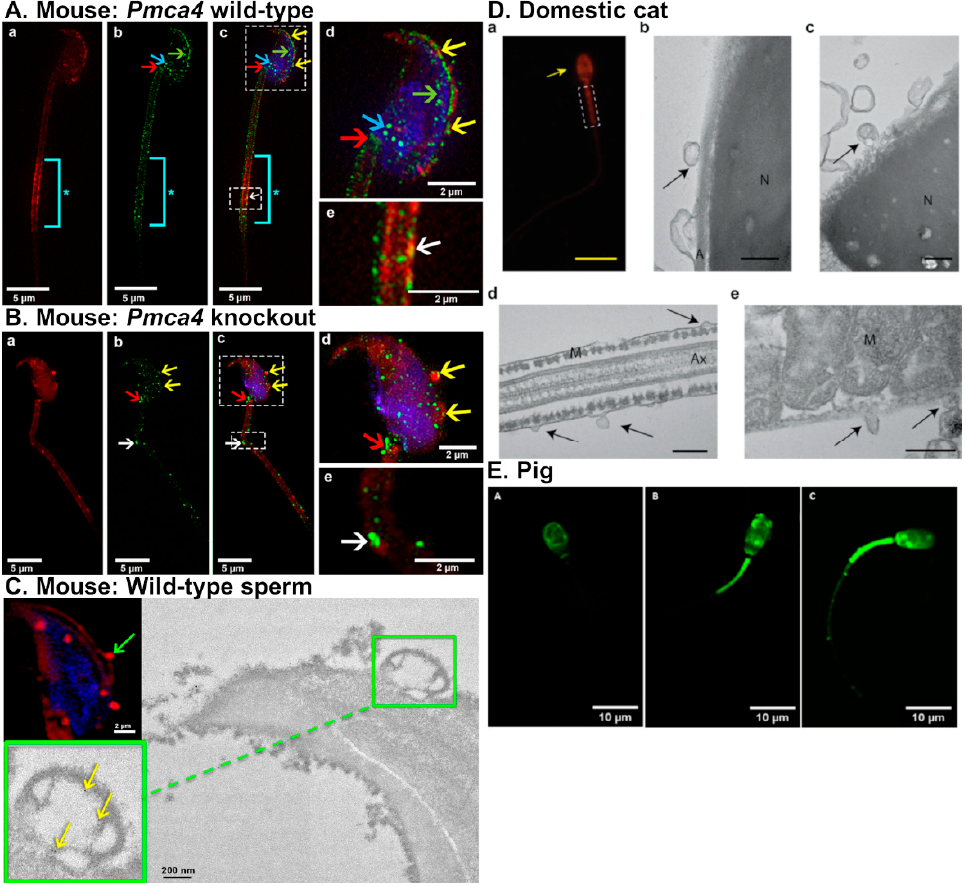
Figure 3. EVs from the oviduct are transferred to the sperm using fusogenic mechanism. ( A – C ) Mouse sperm. ( A ) Pmca4 +/+ and ( B ) Pmca4 − / − sperm incubated with FM4–64FX-labeled oviductosome (red fluorescent signal) and PMCA4 antibody (green fluorescent signal). Yellow arrows; acrosome, white arrows; sperm midpiece, blue arrows; posterior head, red arrows; neck, *; distal midpiece; aqua bar, intense staining of FM4–64FX-labeled oviductosomes. Sperm nuclei were stained with DRAQ5 (blue). ( C ) Fusion of microvesicles on the sperm membrane from WT mice. Green arrow; fusion of FM4–64FX-labeled microvesicles over the acrosome. Transmission electron microscopy (TEM) analysis indicates the fusion (green arrow). Inset shows transfer of gold particles (PMCA4, yellow arrow) from OVS to the sperm membrane over the acrosome. Reprint with permission from [23]. ( D ) Uptake of